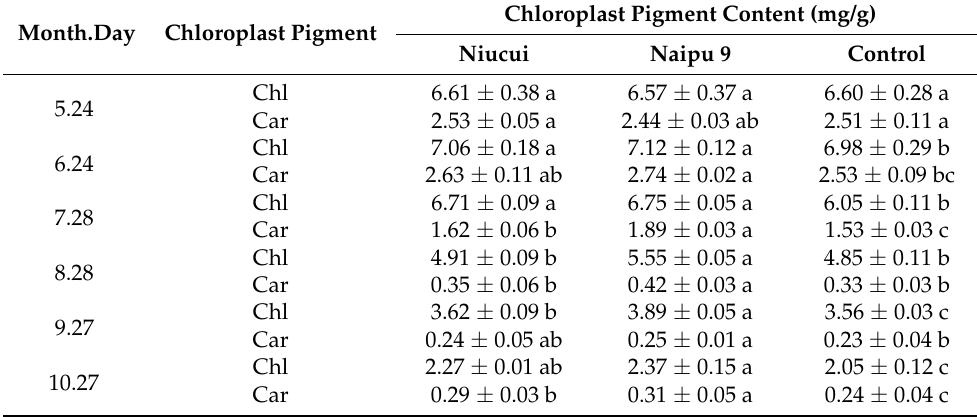
Table 5. Effects of spraying calcium fertilizer on chloroplast pigment content of apple leaves. Month.Day